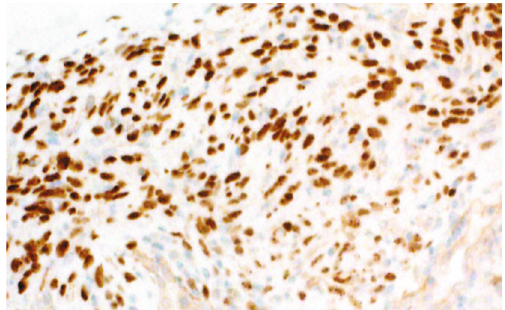
Figure 6: Positive immunoreactivity against STAT6, nuclear type positivity ( ×